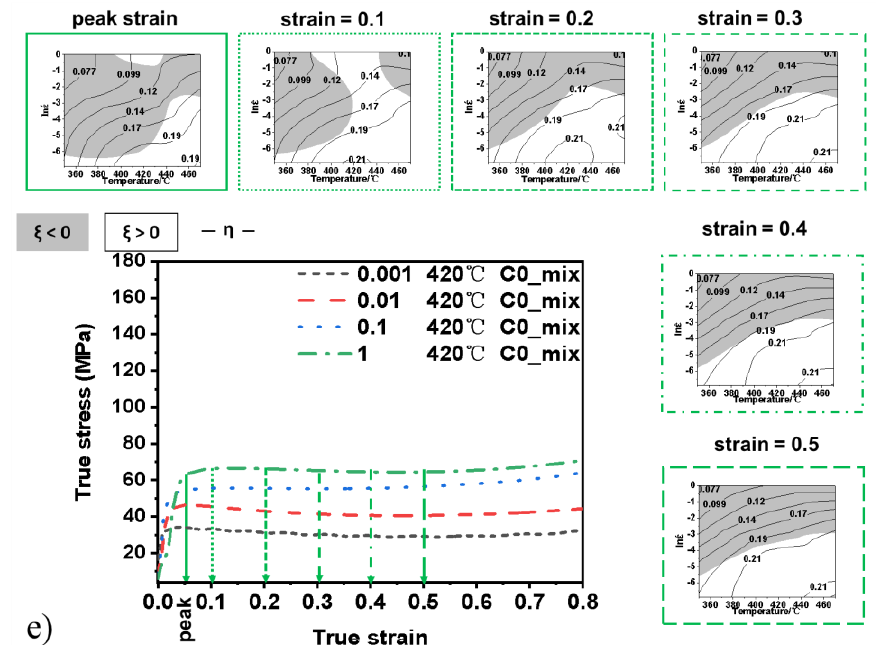
Figure 4. Processing maps of the investigated materials at different strain levels and related compression curves at 420 °C and different strain rates: ( a ) material C0_23; ( b ) material C0_50; ( c ) material C1_23; ( d ) material C0_10; ( e ) material C0_mix.